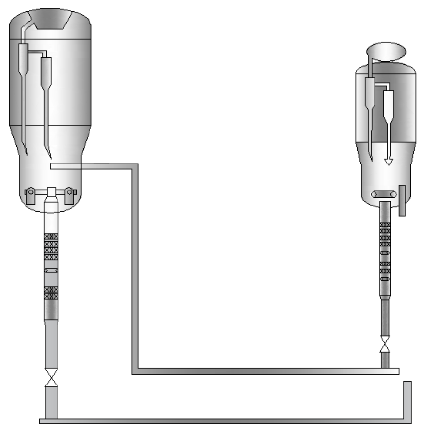
Figure 3. The methanol to olefin unit of an actual chemical plant in China. Table 1. Variable information of the methanol to olefin unit. Variable No. Variable